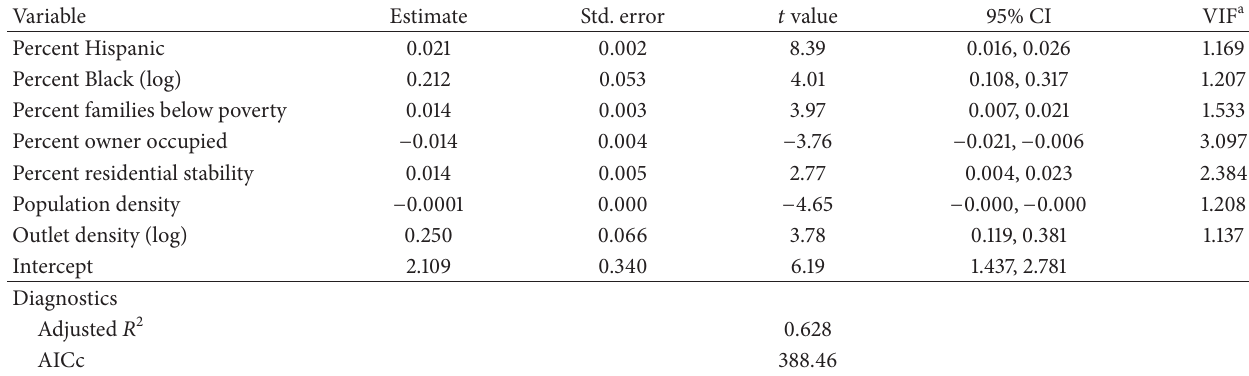
Table 2: Ordinary least squares (OLS) model of violent crime (global model).